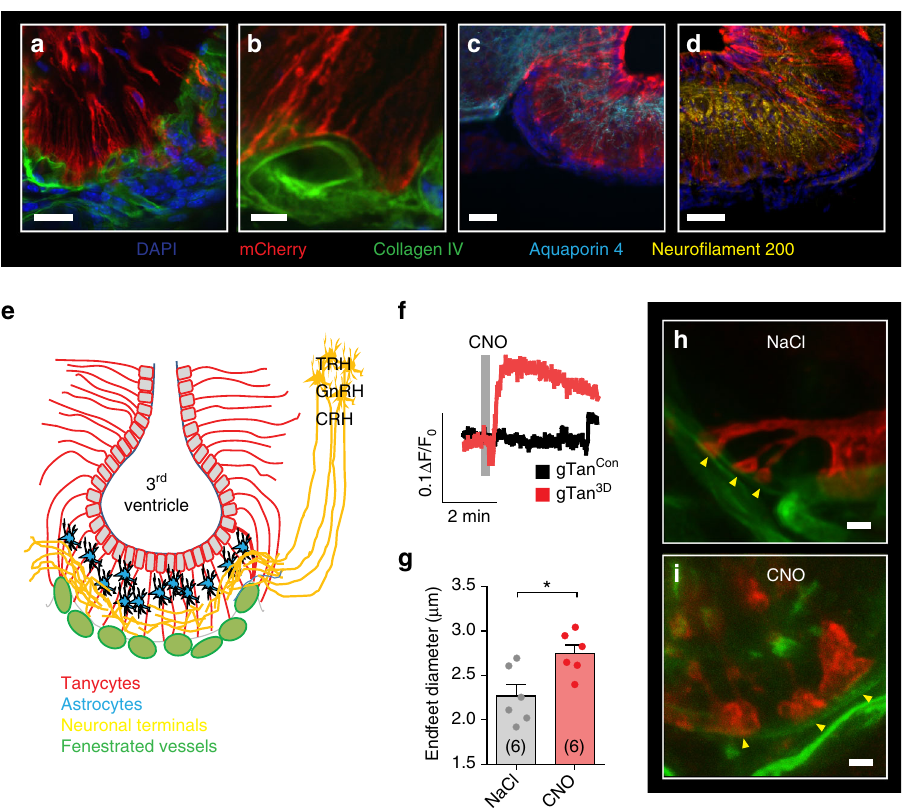
Fig. 3 Morphology of tanycyte endfeet is modulated by the G α q/11 pathway. a – e Characterization of the ME structure in coronary sections. Tanycytes were labeled with the membrane-bound protein hM3D-mCherry by injecting AAV-CAG- fl ex(hM3D-mCherry) in the lateral ventricle of GlastCreER T2 mice and inducing the Cre recombinase with tamoxifen (gTam 3D ). Beta-tanycytes have projections that are branched in their terminal third. The endings of the branches, the so-called endfeet, terminate on the surface of the fenestrated vessels of the portal venous system, located at the bottom of the ME ( a ; red , tanycytes, hM3D-mCherry; green , vessels, collagen IV). Scale bar , 25 µ m. b High-magni fi cation image of tanycytic endfeet in gTam 3D mice. Scale bar , 5 µ m. c Astrocytes are present in a layer beneath the tanycytic cell bodies ( cyan , astrocytes, aquaporin 4). Scale bar , 50 µ m. d Neuronal terminals are located in the central part of the ME ( yellow , neuronal terminals, neuro fi lament 200). Scale bar , 50 µ m. e Schematic drawing of the ME structure. f CNO (10 µ M, gray bar ) increased tanycytic [Ca 2+ ] i in acute brain slices of gTan 3D mice ( red ) in comparison to untransduced control mice (gTan Con , black ). Slices were loaded with the calcium responsive dye Fura-2. Representative traces are shown. g Quantitative analysis of tanycytic endfoot diameters in gTan 3D mice 1 h after injecting 0.9% saline ( gray ; NaCl; i.p.) or CNO ( red , i.p.). Mean endfoot diameters were determined from 15 to 32 endfeet per animal. * p = 0.0147 (two-tailed Student ’ s t -test); mean ± S.E.M.; n , number of animals as indicated. h and i Representative images of tanycytic endfeet ( arrowheads ) in gTan 3D mice 1 h after injecting the vehicle ( h , 0.9% NaCl) or CNO ( i ). Scale bar , 2 µ